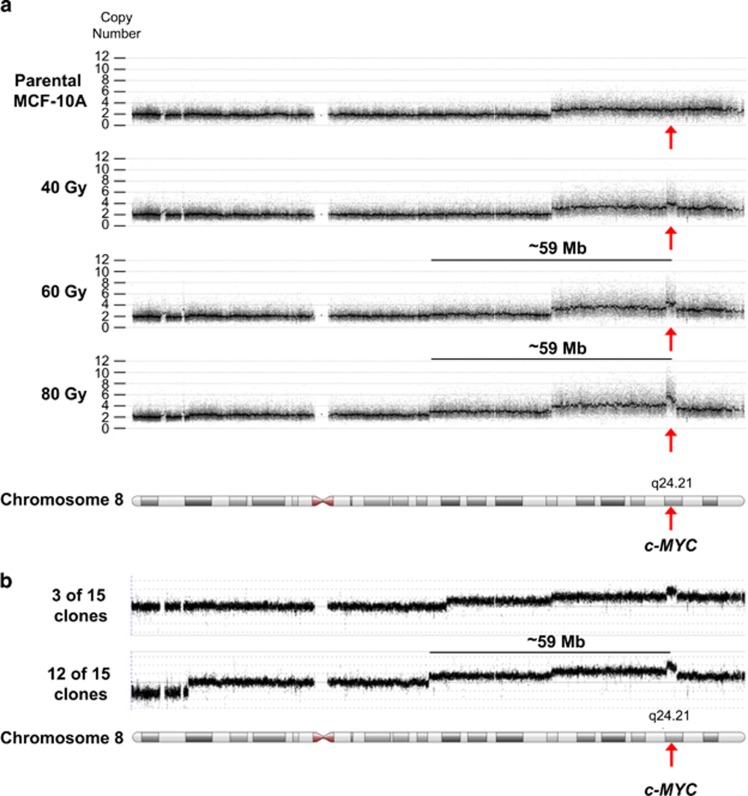
SNP6.0 and Cytoscan array copy number profile of chromosome 8 in parental and irradiated MCF-10A cell populations. Parental MCF-10A and MCF-10A cells irradiated with fractionated X-ray doses of 5 Gy to a cumulative dose of 40, 60 and 80 Gy were assessed by SNP6.0 array (a). Each SNP marker on chromosome 8 is represented and aligned to its position on chromosome 8 as well as its designated copy number state. An ideogram of chromosome 8 is positioned below the SNP marker plots. A 2.5 Mb copy number gain was identified in the 40 Gγ population and spans the c-MYC locus, increasing its copy number state from 3 to 4. The position of c-MYC is highlighted on each SNP marker plot and the chromosome 8 ideogram by a red arrow. An ~59 Mb copy number gain was identified in the 60 Gγ population, which spanned a number of regions with different constitutive copy number states and also encompassed the c-MYC locus, therefore increasing its copy number state further. The ~59 Mb copy number gain first identified in the 60 Gy population was further pronounced in the 80 Gy population. The ~59 Mb region is indicated by the horizontal black line above the SNP marker plots of the 60 and 80 Gy population. Clones from MCF-10A cells irradiated with fractionated X-ray doses of 5 Gy to a cumulative dose of 80 Gy were assessed by Cytoscan array (b). All 15 clones analysed carried the focal 2.5Mb amplification encompassing c-MYC. Twelve of the 15 clones carried the additional ~59 Mb copy number gain discernible from SNP6.0 data and a deletion affecting the p-arm of chromosome 8. Three of the 15 clones did not carry the 59 Mb copy number gain or the p-arm deletion, but carried a novel copy number gain also encompassing the c-MYC gene.